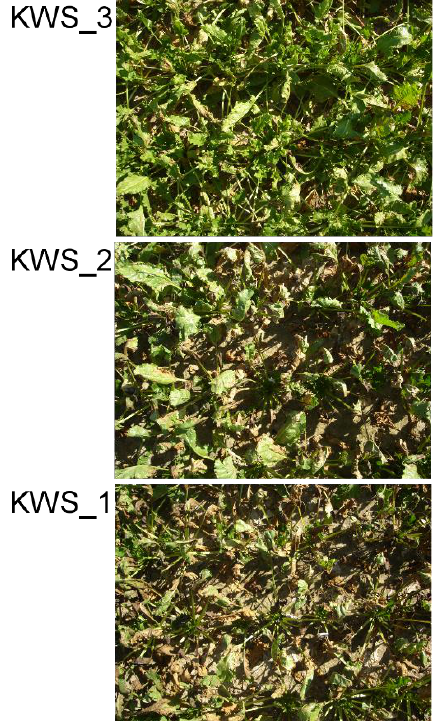
Figure 1. Photographs of representative plants in plots planted with genotypes KWS_3 (low susceptibility, disease score 5), KWS_2 (intermediate susceptibility, disease score 7.5), and KWS_1 (high susceptibility, disease score 9) at Plattling experimental field